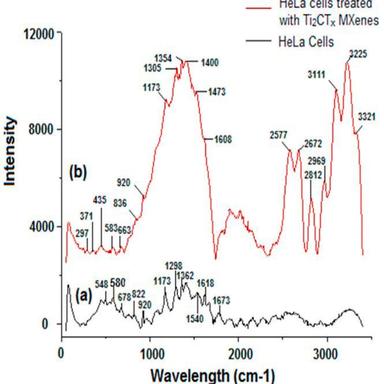
Raman spectra of (a) control treated HeLa cells and (b) 500 μg/mL of Ti2CTx MXenes treated HeLa cells in 2D cell culture.